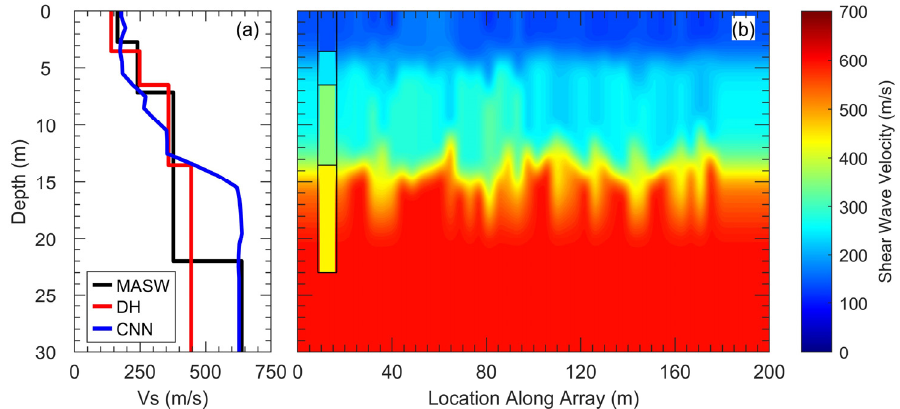
Figure 3. V S profiles used to develop the four starting models for FWI, including: ( a ) 1D V S profiles from MASW, downhole, and CNN analyses, and ( b ) the pseudo ‐ 2D V S image from MASW with the DH results shown at the location of the borehole.